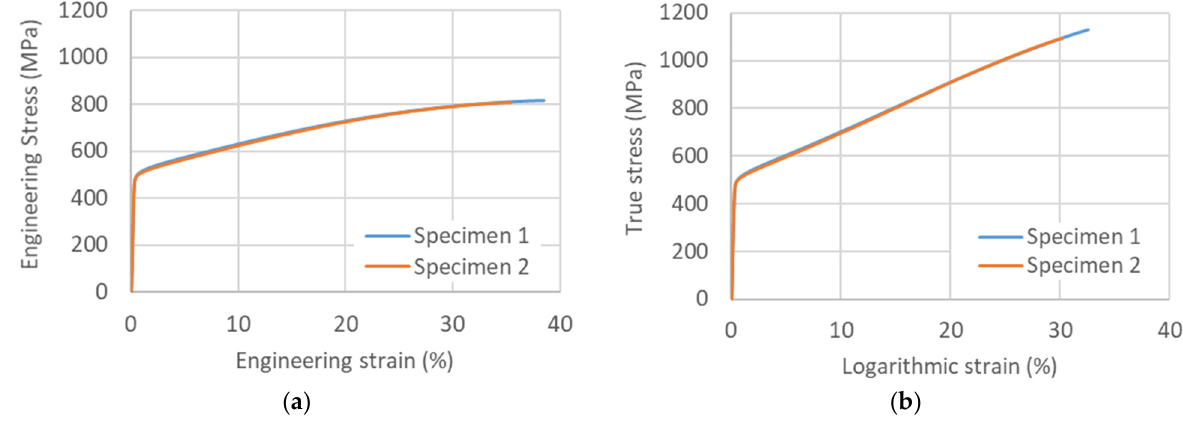
Figure 11. Stress-strain curves: ( a ) Engineering; ( b ) True.